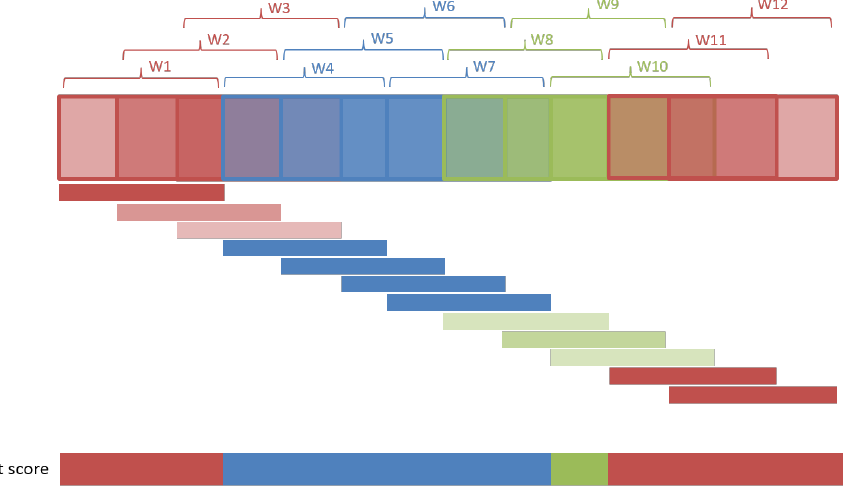
Figure 16. Best-score postprocessing option. The darker the color, the larger the confidence of the prediction. After postprocessing, an outlier removal procedure is applied to the predictions.